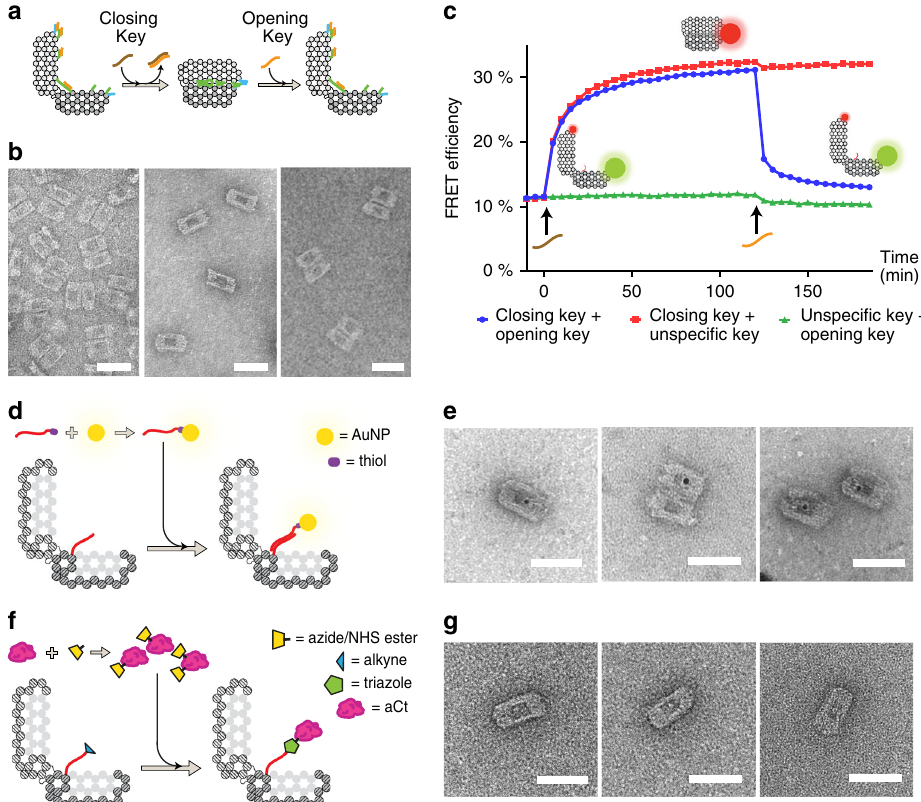
Fig. 2 Reversible closing – opening mechanism and cargo loading. a Schematic of the closing – opening mechanism of the DNA nanostructure. b Transmission electron microscopy (TEM) images showing open, closed and reopened DV samples. Original TEM images in Supplementary Fig. 6. c FRET ef fi ciency measured on the open Cy3/Cy5-conjugated DV. The blue line shows values measured after the closing key is added (brown), and — subsequently — after the opening key is added (orange). d Schematics of non-covalent cargo-loading mechanism: 5 nm gold nanoparticles (AuNPs) were reacted with thiol- modi fi ed DNA strands and incubated together with open DV molecules exposing a complementary CAS staple strand within the cavity. e TEM images of AuNP-loaded DV. AuNPs are detectable as black dots within the DV cavity. Original TEM images in Supplementary Fig. 10a – c. f Schematics of covalent cargo-loading mechanism: the endopeptidase aCt was conjugated with azide-NHS ester handles, and then reacted together with open DV exposing an alkyne-modi fi ed CAS staple strand within the cavity. Copper(I)-catalysed alkyne-azide cycloaddition reaction induces the formation of covalent DNA origami-enzyme conjugates. g TEM images of the aCt-loaded DV after incubation with closing key. Enzymes are detectable as white spots within the DV cavity. Original TEM images in Supplementary Fig. 10d – f. Scale bar, 50